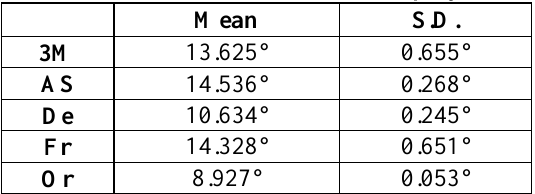
Table 6: Molar tubes torsional play.